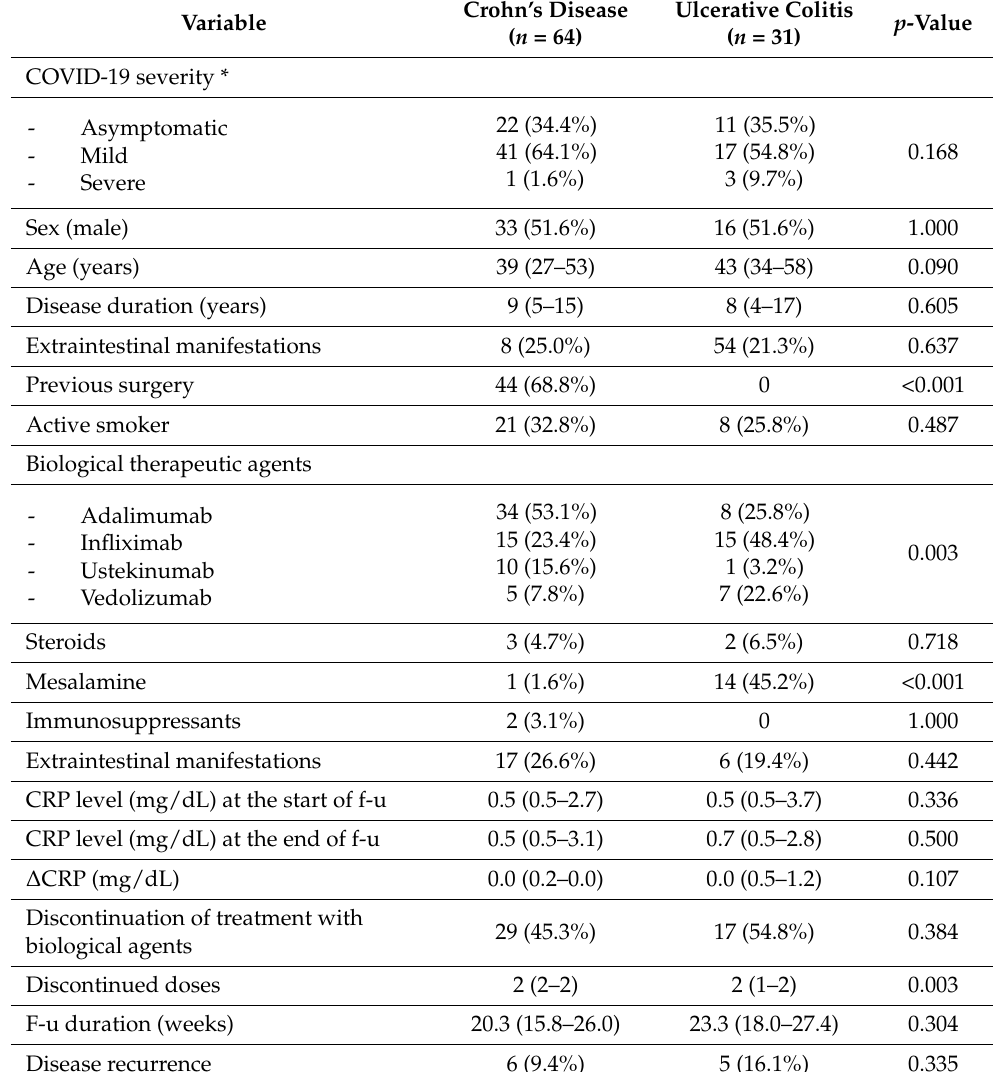
Table 4. Clinical characteristics of the 95 SARS-CoV-2-positive